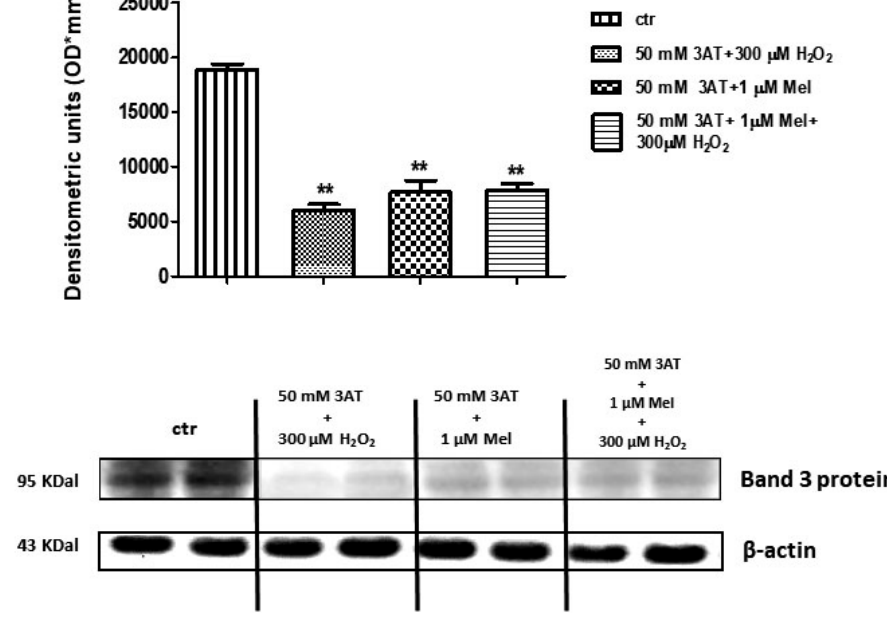
Figure 10. Expression levels of Band 3 protein measured in untreated erythrocytes (ctr), or in 50 mM 3-AT + 300 µM H 2 O 2 - or in 50 mM 3-AT + 1 µM Mel or in 50 mM 3-AT + 1 µM Mel + 300 µM H 2 O 2 - treated erythrocytes, detected by Western blot analysis. ** p < 0.01 vs. ctr; as determined by one way ANOVA followed by Bonferroni’s post hoc test (N = 5).